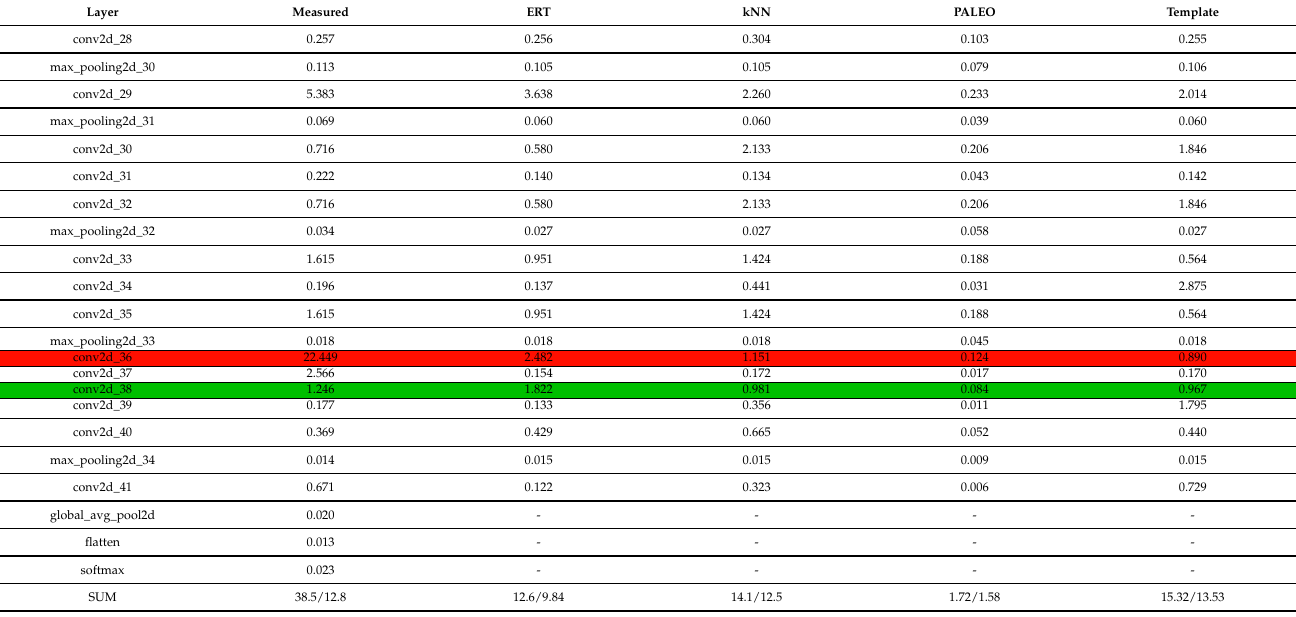
Table 5. Comparison of the layerwise measurements of the execution time with the predictions of the different approaches. The layer configuration of the convolutional layer with the large underestima- tion of the inference latency is marked in red, the green row represents a similar layer which achieved a significantly shorter inference latency. The inference latency was measured and predicted in ms. The last line compares the total inference times with and without the inclusion of the erroneous